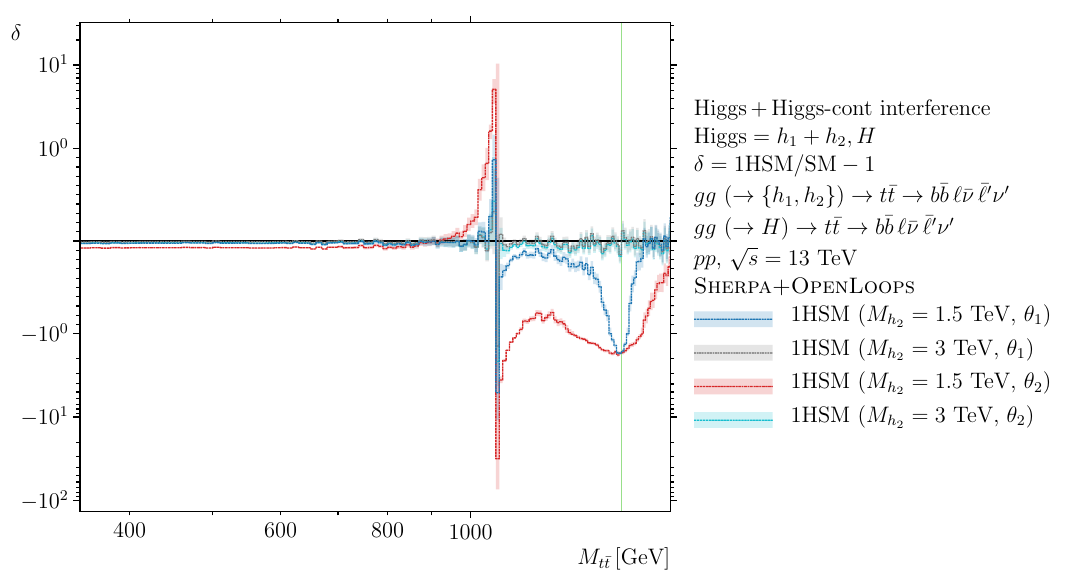
Figure 20 . M distributions of the relative deviation δ = R t ¯ t its interference with the background in the 1HSM ( M h ) t ¯ t b ¯ b (cid:20) ¯ ν ¯ (cid:20) (cid:31) ν (cid:31) in pp collisions at √ s = 13 TeV. R is the ratio of SM for gg ( h 1 , h 2 , H } → → → { σ ( h 1+2 +I(C)) to σ ( H +I(C)). Other details as in figure 4.